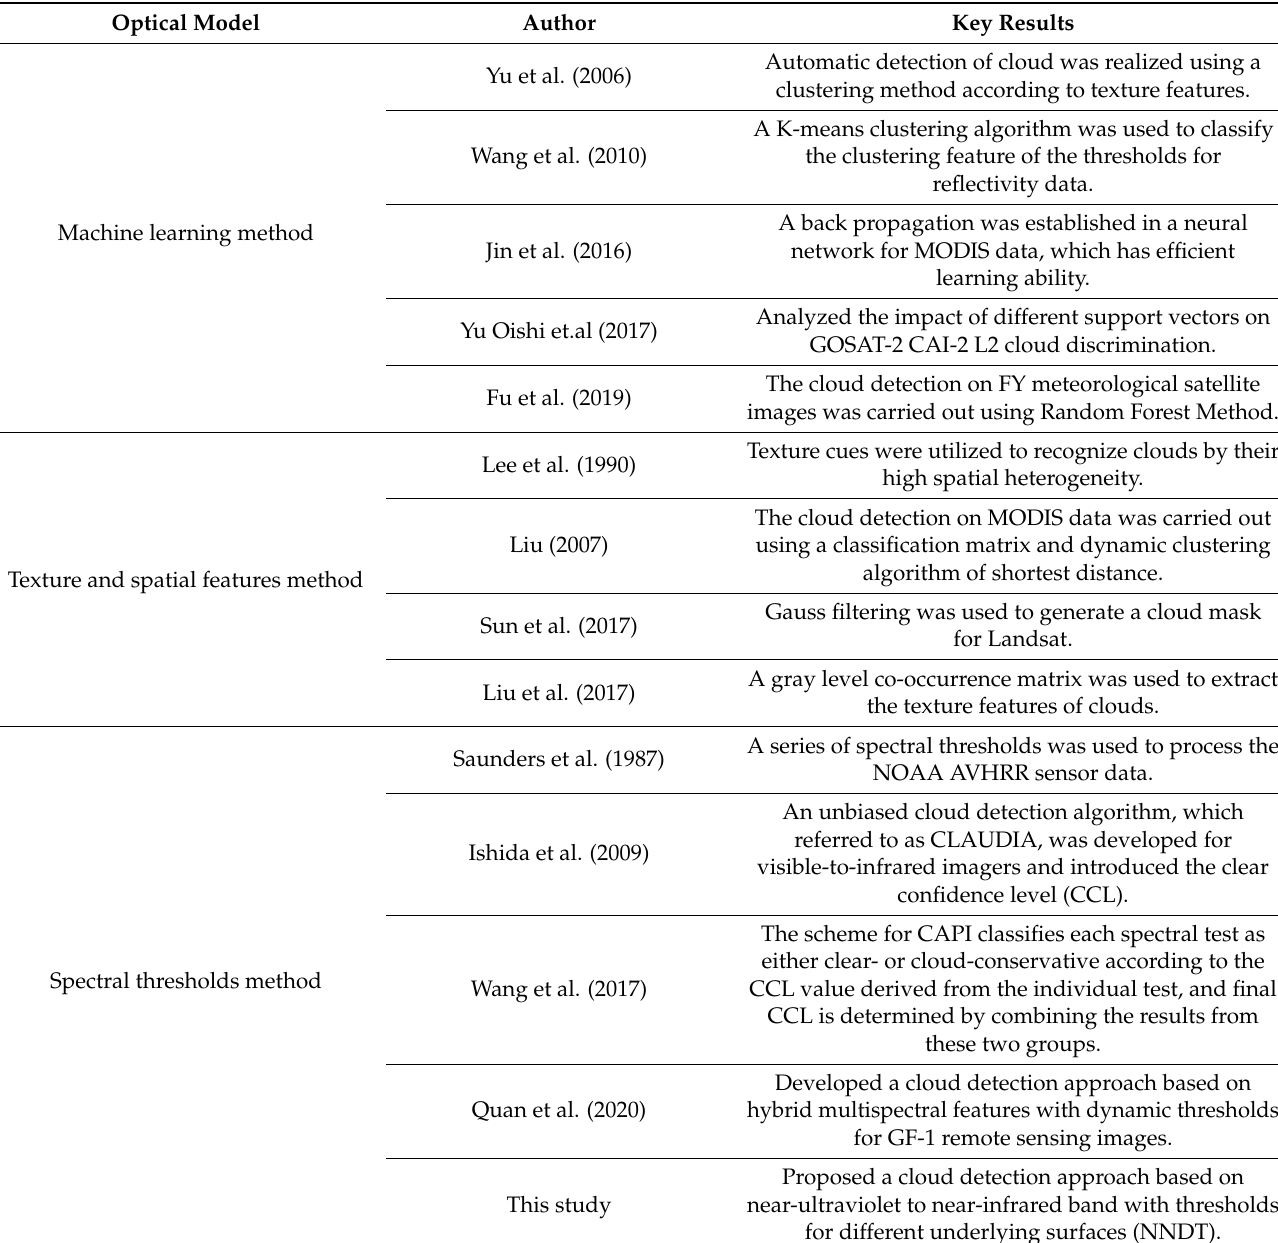
Table 2. Summary of three classes of cloud detection